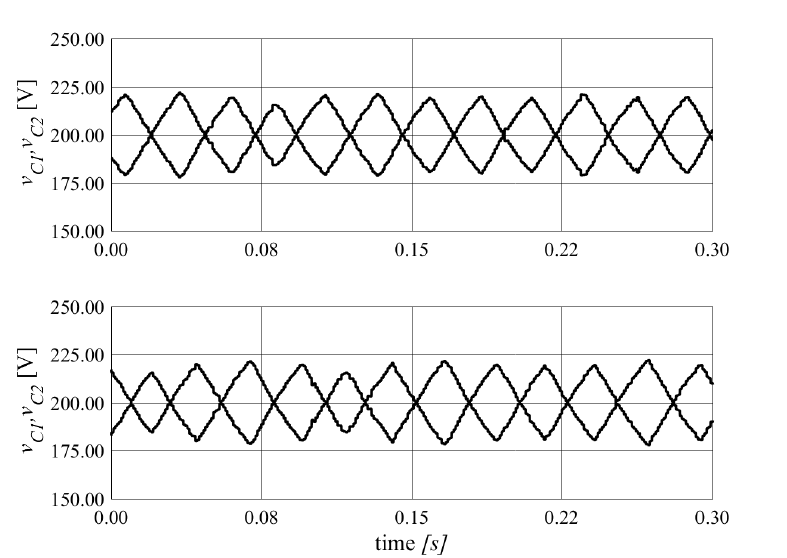
Figure 14. Experimental result: capacitors voltages for the traditional SVM (upper trace) and proposed